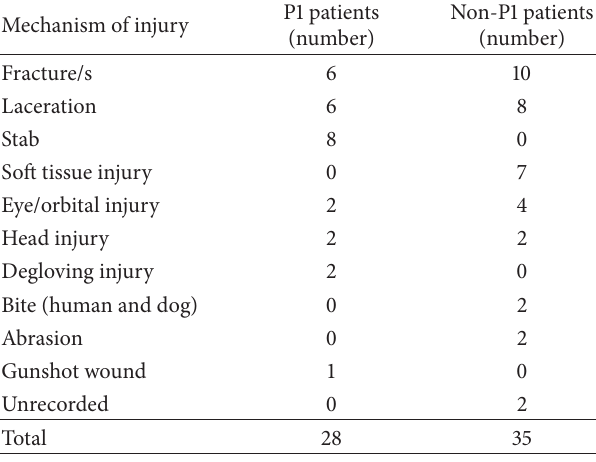
Table 1: The mechanisms of injury of the 63 patients presenting at the ED in a 24-hour